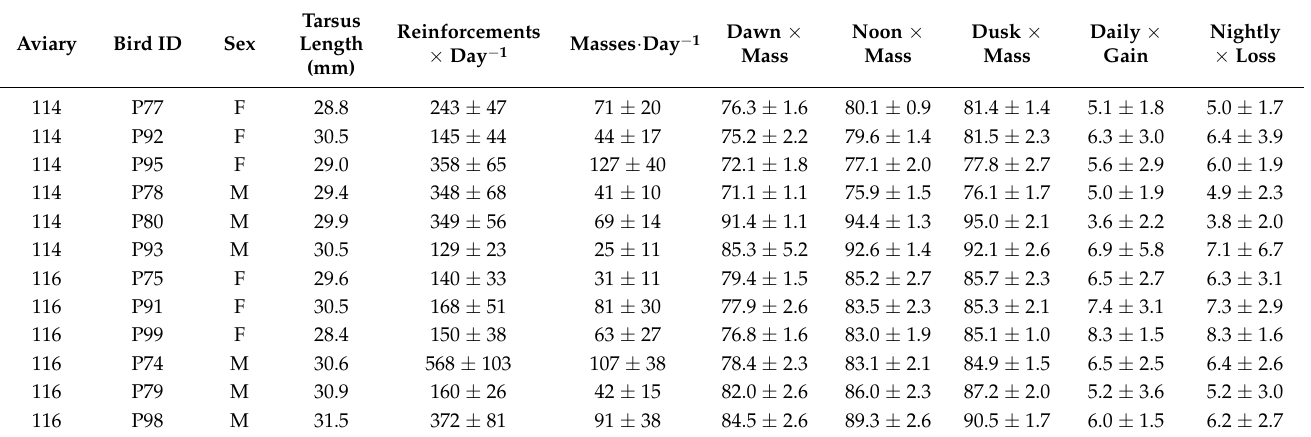
Table 1. Details of birds and descriptive statistics (mean ± sd) for reinforcements earned and body mass data †